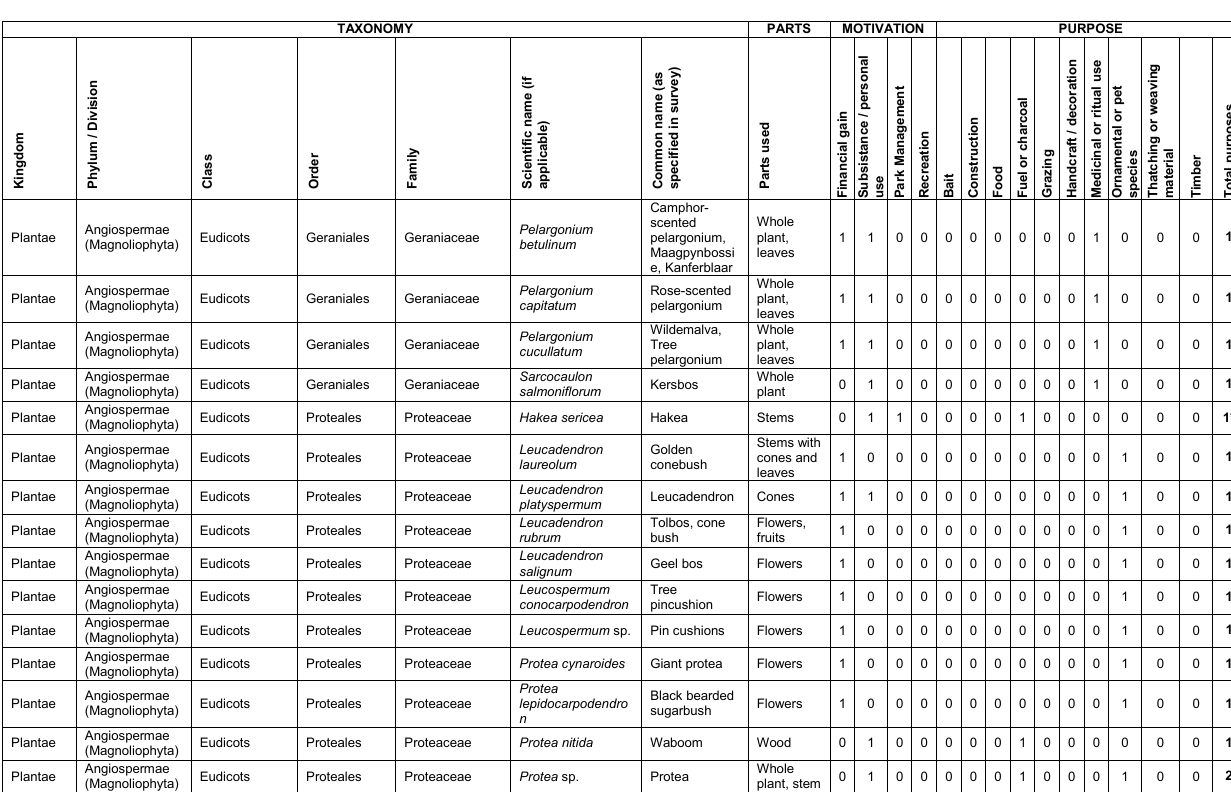
Plantae Angiospermae (Magnoliophyta) Eudicots Proteales Proteaceae Protea nitida Waboom Wood 0 1 0 0 0 0 0 1 0 0 0 0 0 0 1 Plantae Angiospermae (Magnoliophyta) Eudicots Proteales Proteaceae Protea sp. Protea Whole plant, stem 0 1 0 0 0 0 0 1 0 0 0 1 0 0